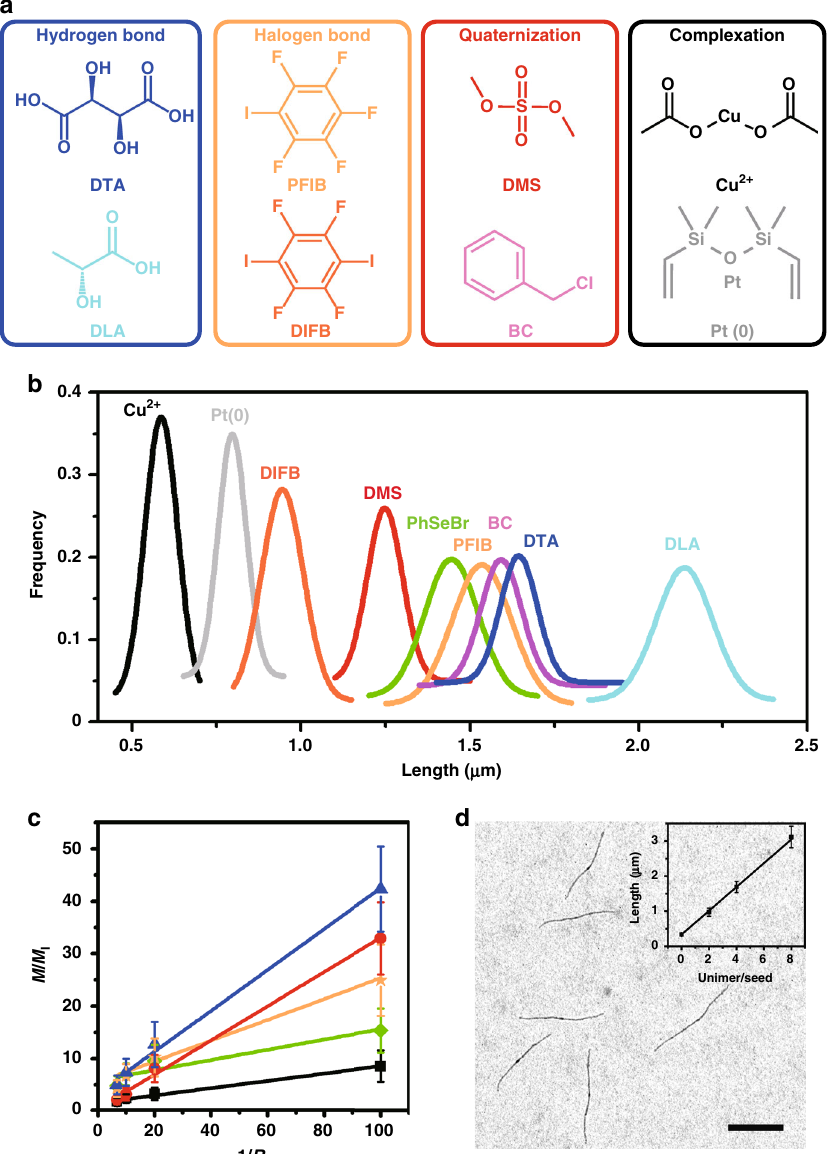
Fig. 3 The initiated assembly by small-molecule initiators. a The chemical structures of all the small-molecule initiators used in this study. b The Gaussian distribution of the micelle lengths from the micelles initiated with different initiators at C P = 0.025mg/mL and R I = 5%. c Linear relationship between ( M / M I ) and (1/ R I ) for DTA (blue triangle), DMS (red circle), PFIB (orange star), PhSeBr (green diamond), and Cu 2 + (black square) at C P = 0.025mg/mL (error bars represent the s.d.). d TEM image of the cylindrical micelles produced from the thermo-seeded growth process with a unimer/seed = 4:1. Inset shows the linear relationship between the cylindrical micelle length and the unimers to seed mass ratio. Scale bar is 1 μ